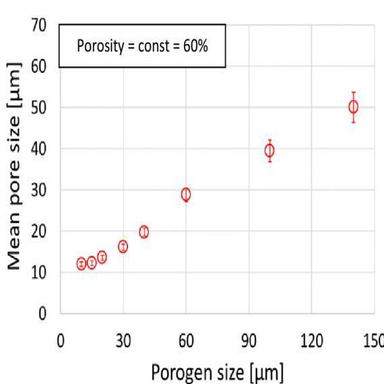
Mean pore size of new material scenarios with constant porosity and increasing porogen size.